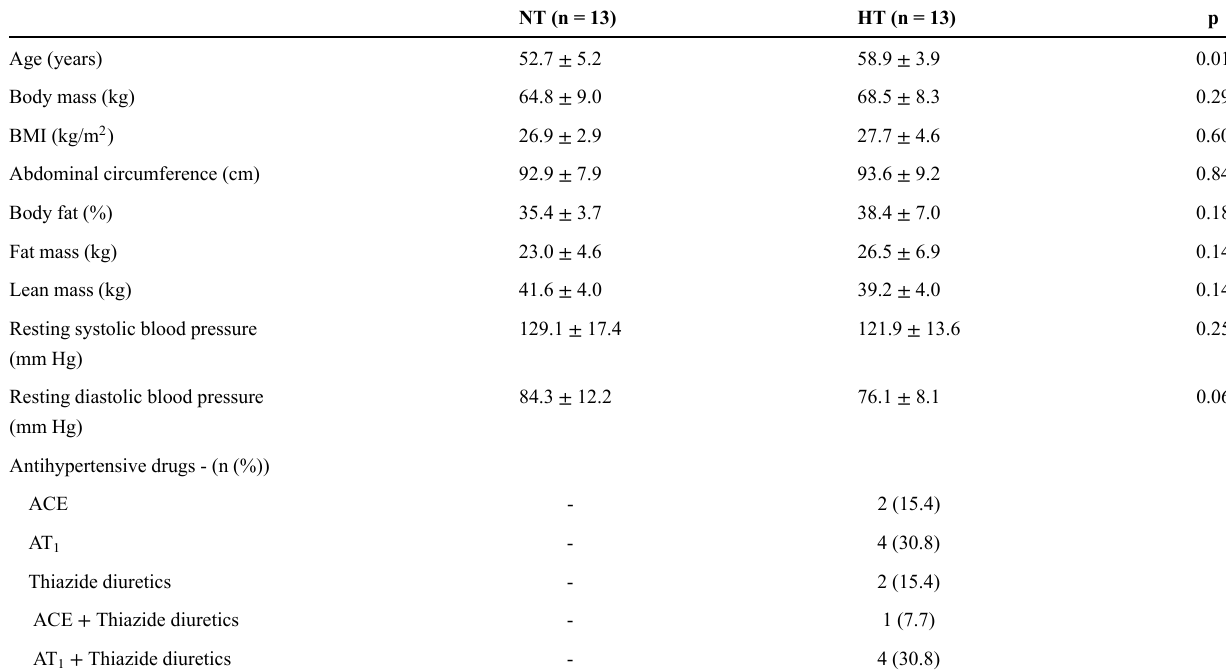
Table 1 - Volunteers